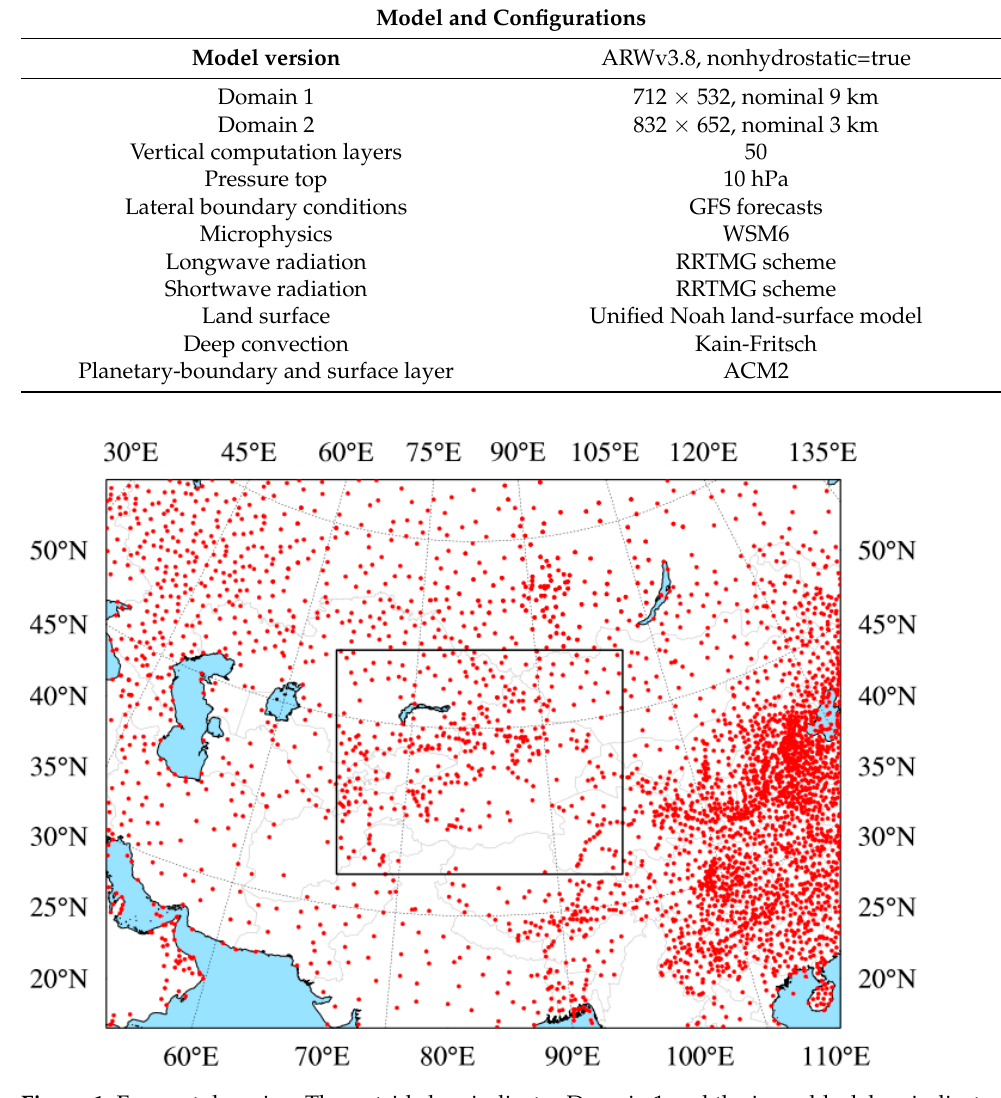
Figure 1. Forecast domains. The outside box indicates Domain 1 and the inner black box indicates Domain 2. The red dots refer to SYNOP stations.